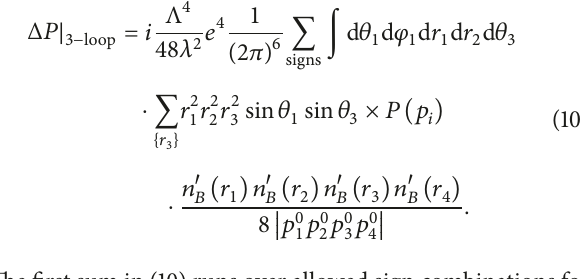
Figure 7: The two-loop pressure contribution (a) and moduli of the three-loop pressure corrections (b), 1/3Δ𝑃| 3− 2/3Δ𝑃| 3− loop ,𝑠𝑡 (dashed), divided by the massive sector one-loop pressure expressions from [22], while the dots and triangles are the respective 𝑠𝑠 and 𝑠𝑡 Monte Carlo (MC)